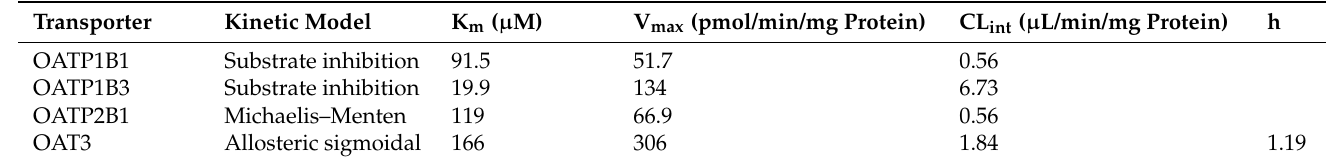
Figure 9. Concentration-dependent uptake of EZE-Ph into OATP1B1- ( A ), OATP1B3- (B), OATP2B1- ( C ), and OAT3- ( D ) expressing HEK293 cells. The uptake time was 5 min. Each point was presented as mean ± S.D. ( n = 3). Table 3. Kinetic parameters for the uptake of EZE-Ph into human OATP1B1-, OATP1B3-, OATP2B1-, and OAT3-expressing HEK293 cells.